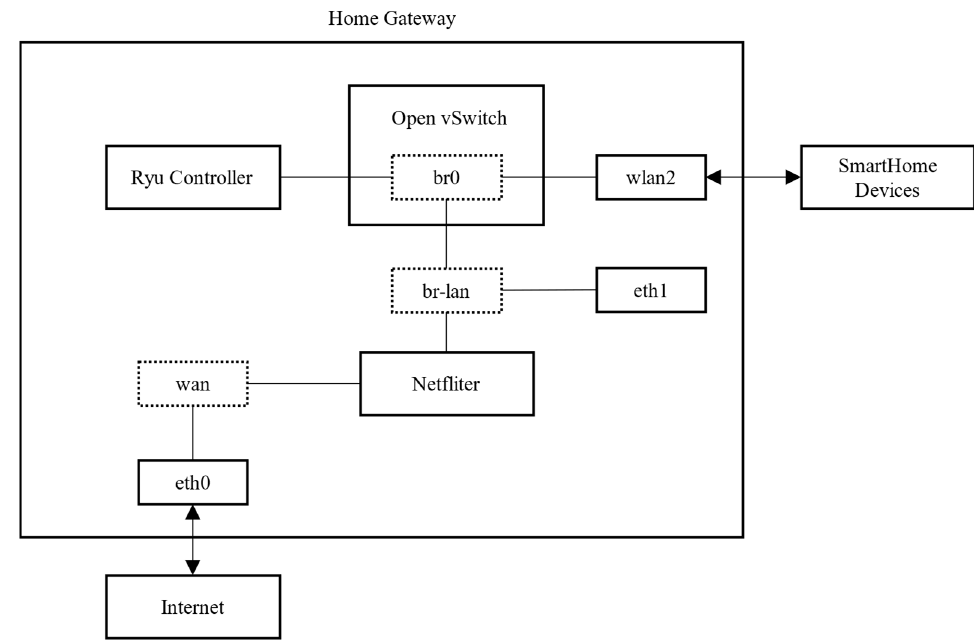
Figure 7. Packet capture framework.